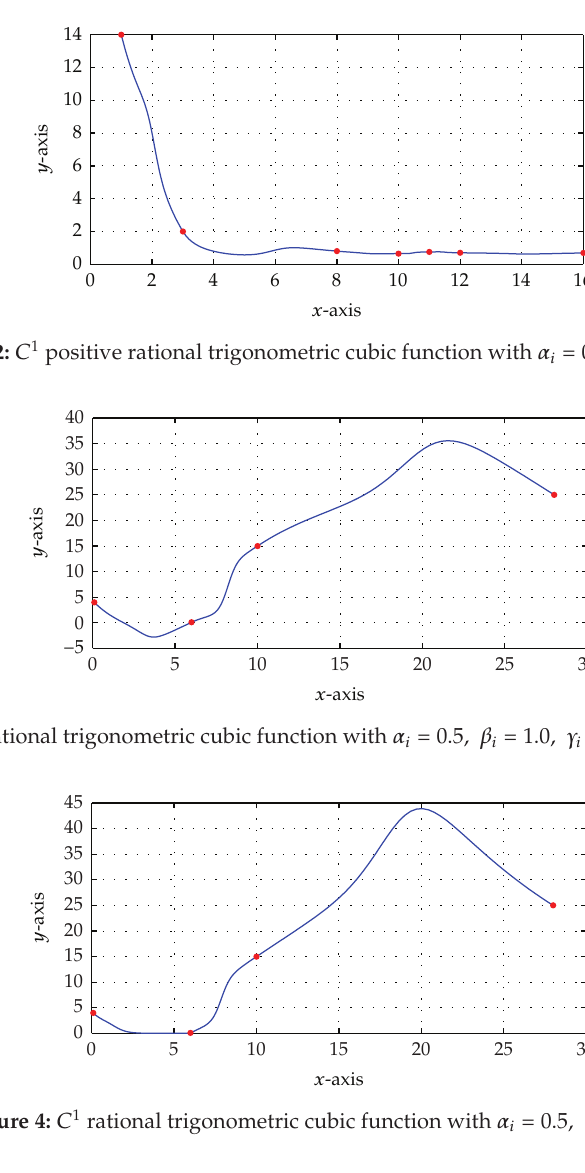
Figure 1: C 1 rational trigonometric cubic function with α i (cid:8) 0 . 5 , β i (cid:8) 1 . 0 , γ i (cid:8) 0 . 5 , and δ i (cid:8) 1 . 0.